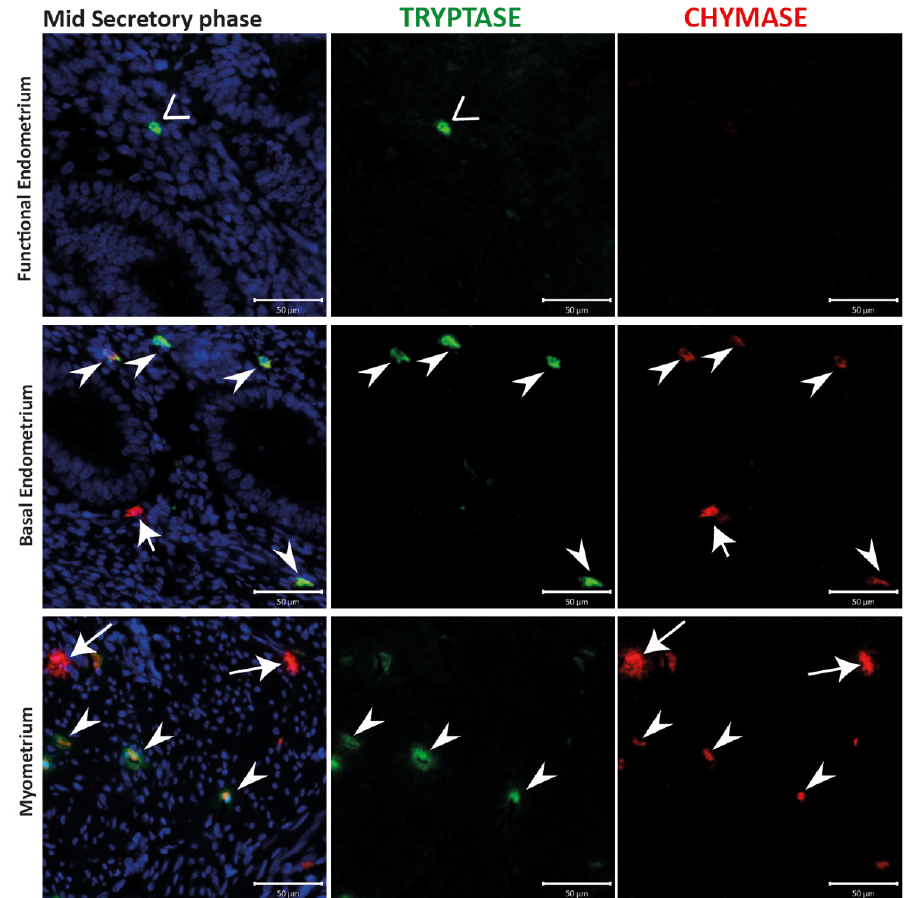
Figure 3. A population of chymase positive mast cells that did not express tryptase was identified in uterine tissue samples from the mid secretory phase. The endometrial compartment shows three different mast cell (MC) subtypes: tryptase single positive, chymase single positive and tryptase and chymase double positive. Basal endometrial MCs are chymase+/tryptase- single positive and double positive, instead functional endometrium MCs are fewer in number and show a chymase-/tryptase+ phenotype. MCs during the secretory appeared to be activated in the myometrium, releasing both proteases from the cytoplasm. (n=3) (Arrowheads: MC